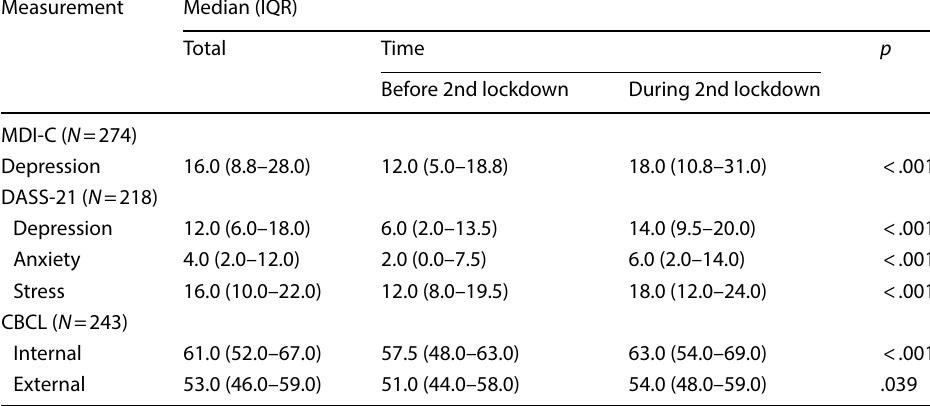
Emotional Distress Scores in Children and Parents by